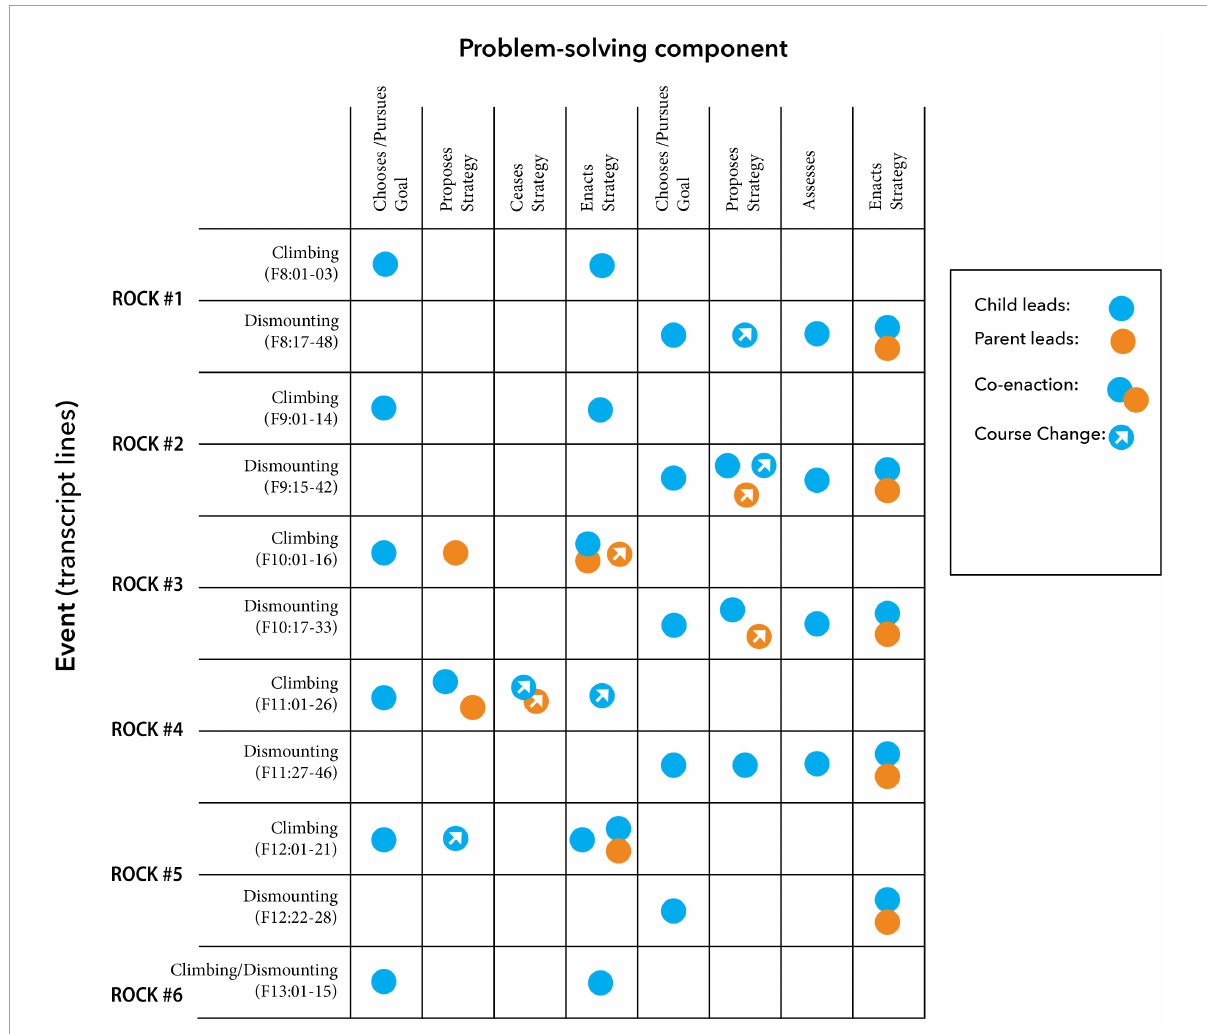
FIGURE14 Matrix for visualizing the decomposed analysis of the “Rocks” clip. Events in the y -axis are collapsed vertically so that the climbing activities and dismounting activities are seen together in a single row for each rock.